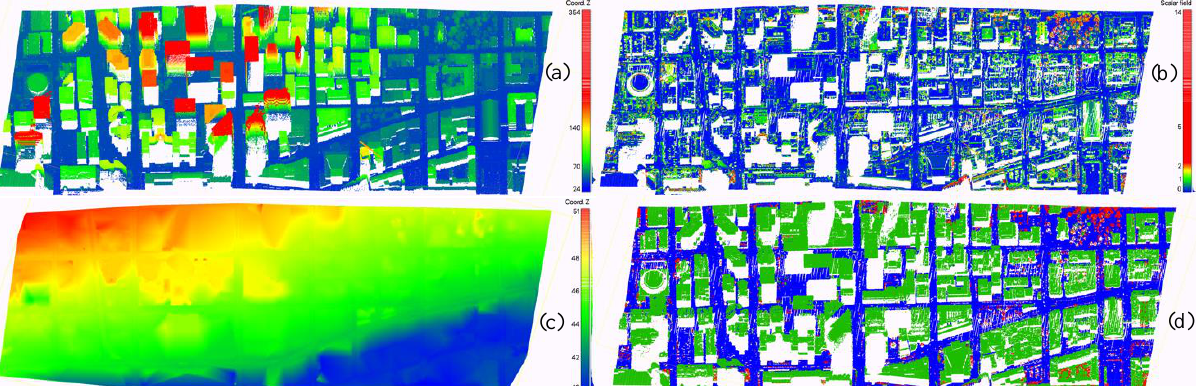
Figure 1. The proposed classification pipeline applied to ALS data (~6pts/sqm) over a part of Toronto, Canada (ISPRS benchmark dataset - Niemeyer et al., 2014; Rottensteiner et al., 2014): (a) original data, (b) geometric feature extraction (local planarity shown), (c) DEM extraction, (d) classification with Deep Learning. The point cloud in (d) is colored as ground level objects - GLOs (blue), roofs (green) and vegetation